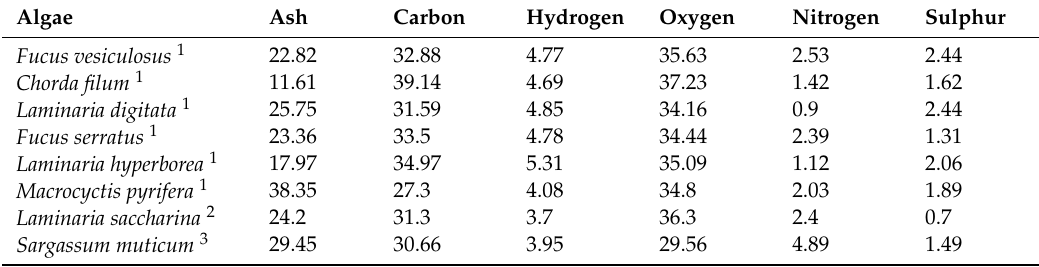
Table 4. Compositional data (% dw) for species of seaweed being considered as potential biofuels. Algae Ash Carbon Hydrogen Oxygen Nitrogen